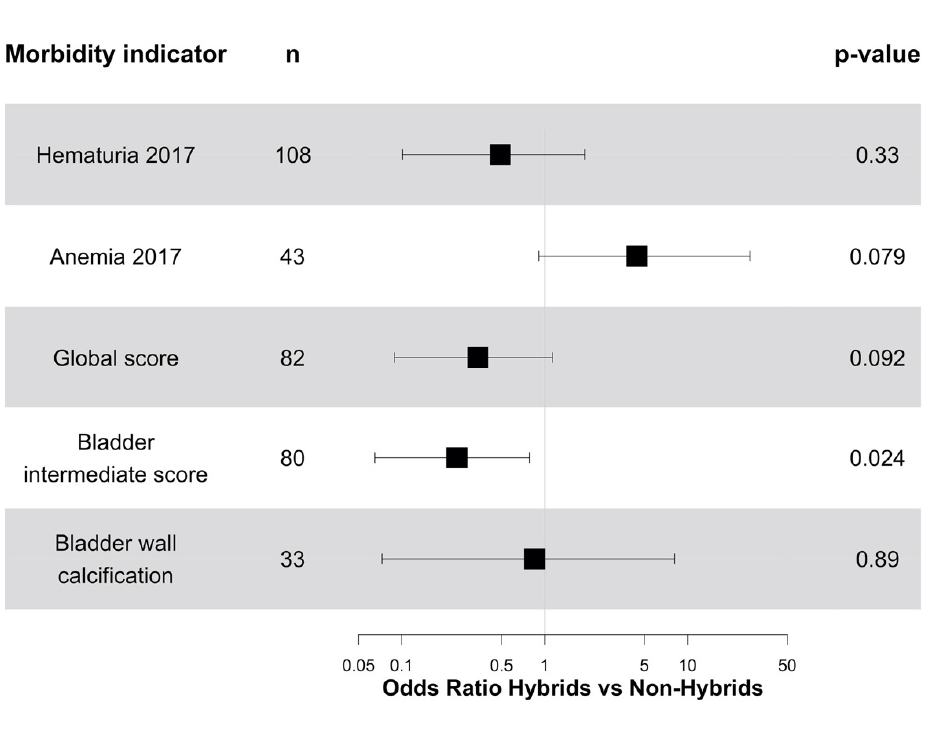
Figure 3. Odds ratios (points) and 95% confidence intervals (horizontal lines) of decreased levels of morbidity in response to treatment with praziquantel among children in Senegal in 2017, depending on the detection of S. haematobium-S. bovis hybrids pre-treatment and adjusted for intestinal and urogenital infection intensities before treatment, age, sex, and study site.